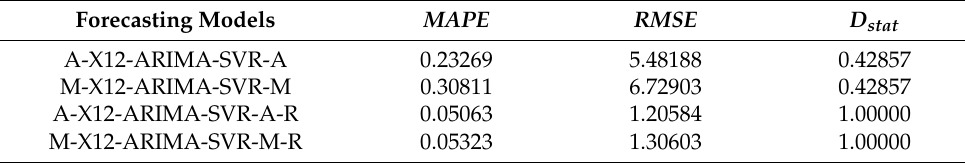
Table 2. The prediction performance of gasoline consumption in Qinghai.